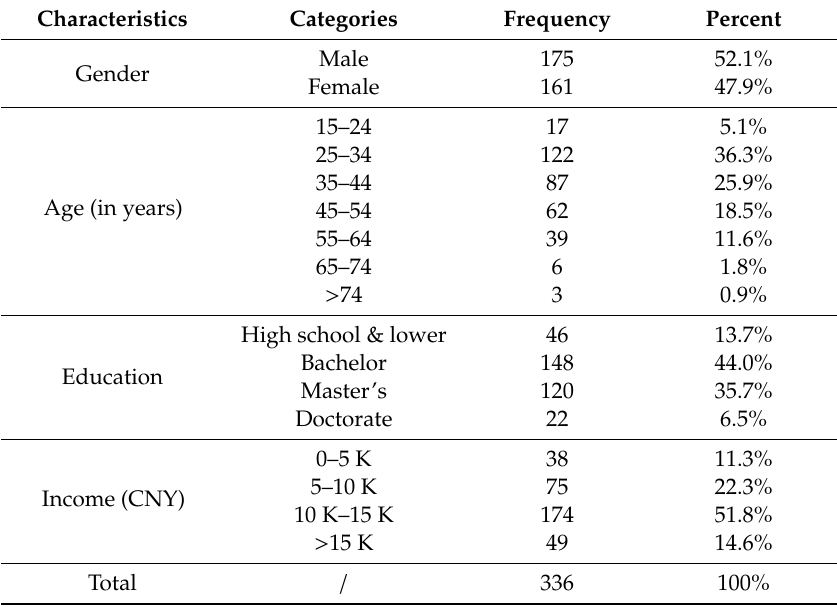
Table 2. Demographics of the survey respondents ( N =